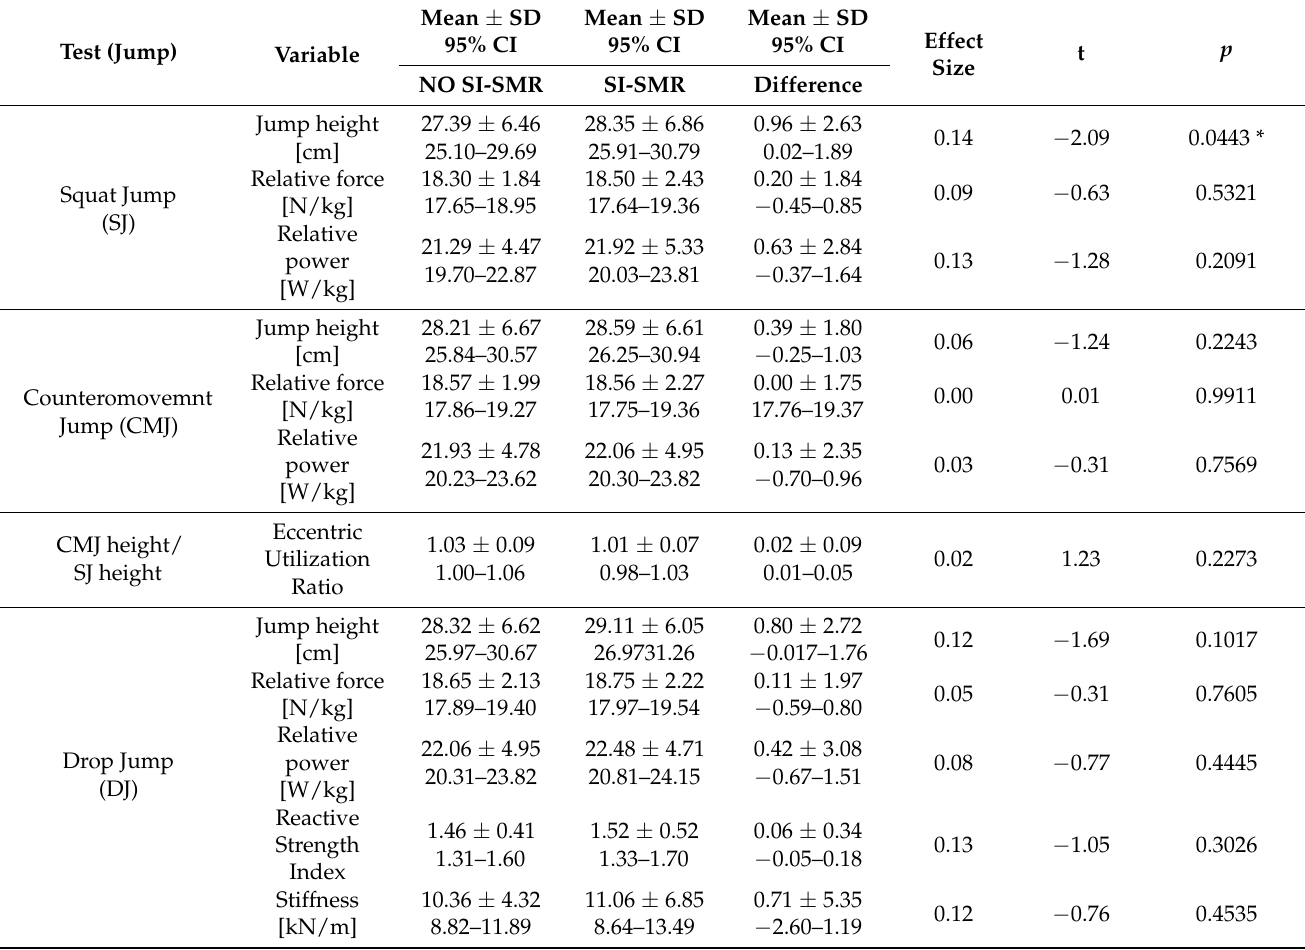
Table 2. Paired t-test results between jump parameters pre- (No SI-SMR) and post-intervention